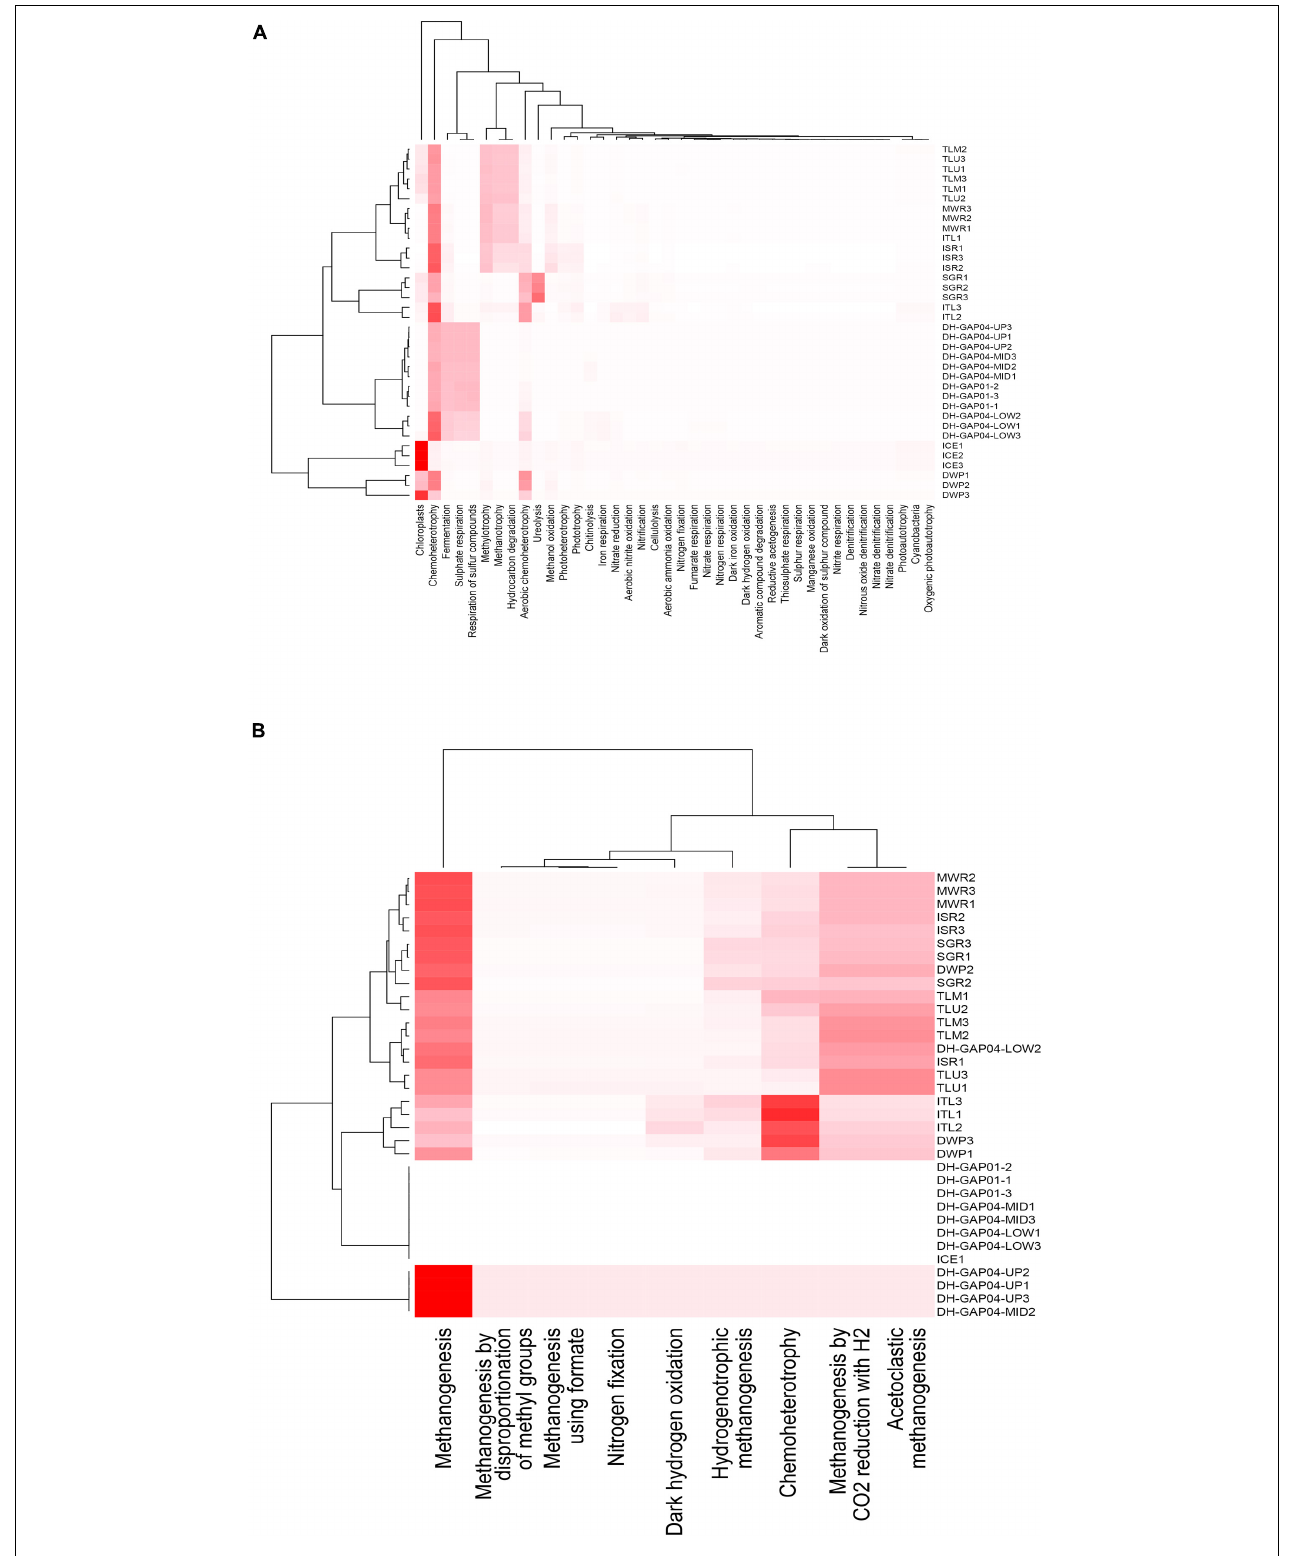
FIGURE 6 | Heatmap cluster based on the relative functional abundance predictions of the (A) bacterial and (B) archaeal communities based on FAPROTAX. The cladograms were calculated using the Bray-Curtis dissimilarity model in phyloseq.